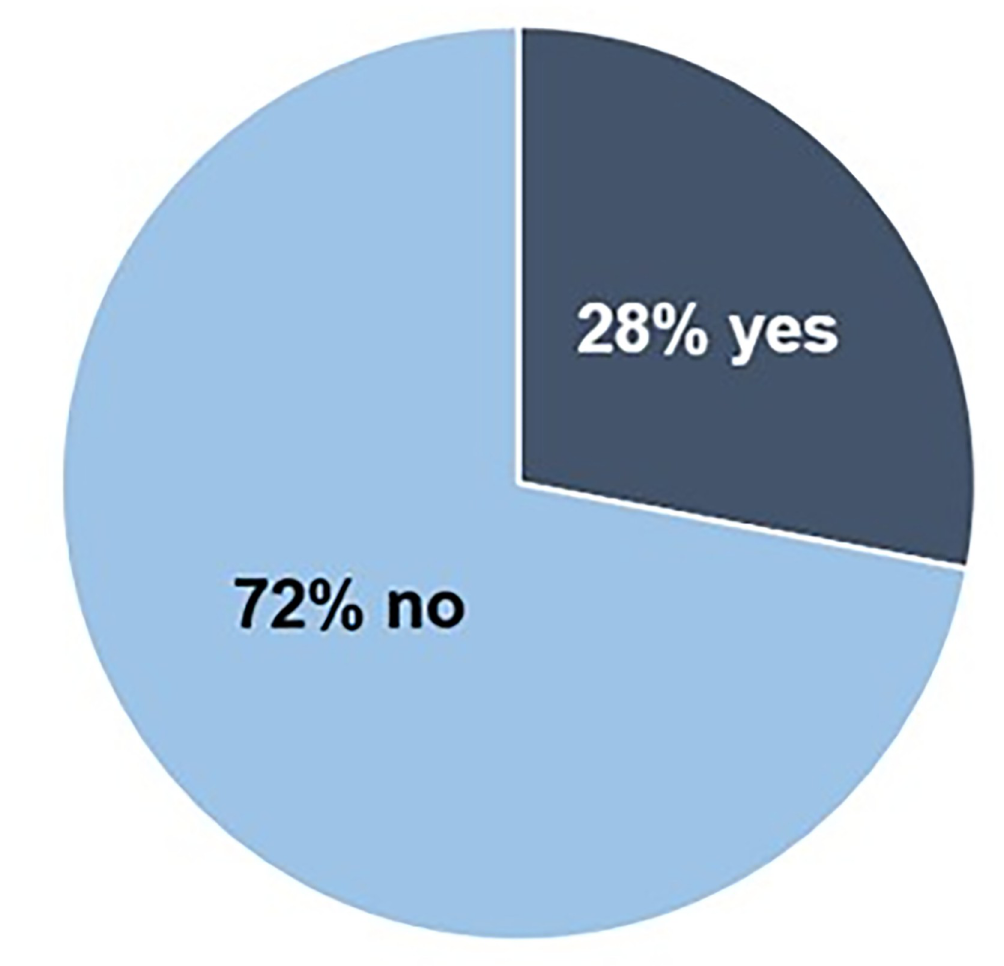
Fig 3. Participants report on whether their institution offers formal science communication training. Participant responses to the question “Did you have formal science communication training, for a public audience, at your graduate institution?” Data is shown as percent responding, with 72% responding no and 28% responding